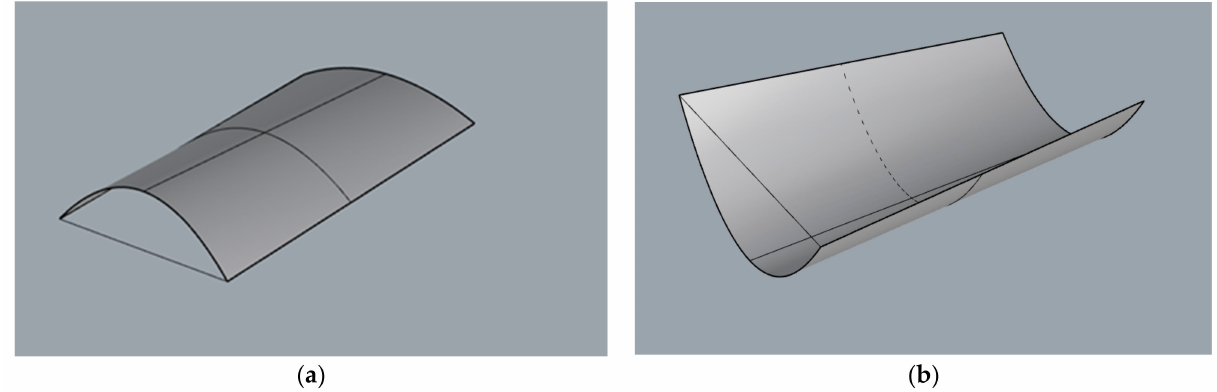
Figure 2. Example modules of cylindroid: ( a ) witch positive arch; ( b ) witch negative arch.